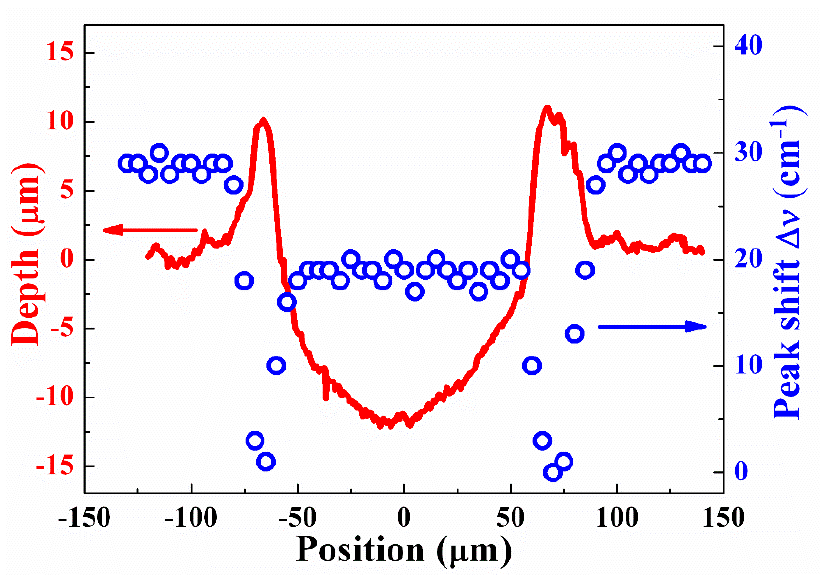
Figure 3. A typical profile of the peak shift of the characteristic R-line of α -Al 2 O 3 scale across the indent created by a 200 µm radius indenter with 30 N loading after oxidation at 1200 °C for 25 h. The stress can be derived from the peak shift ( ∆ ν ) of the characteristic R-lines of the Cr 3+ luminescence relative to the stress-free alumina given by [25,26]: